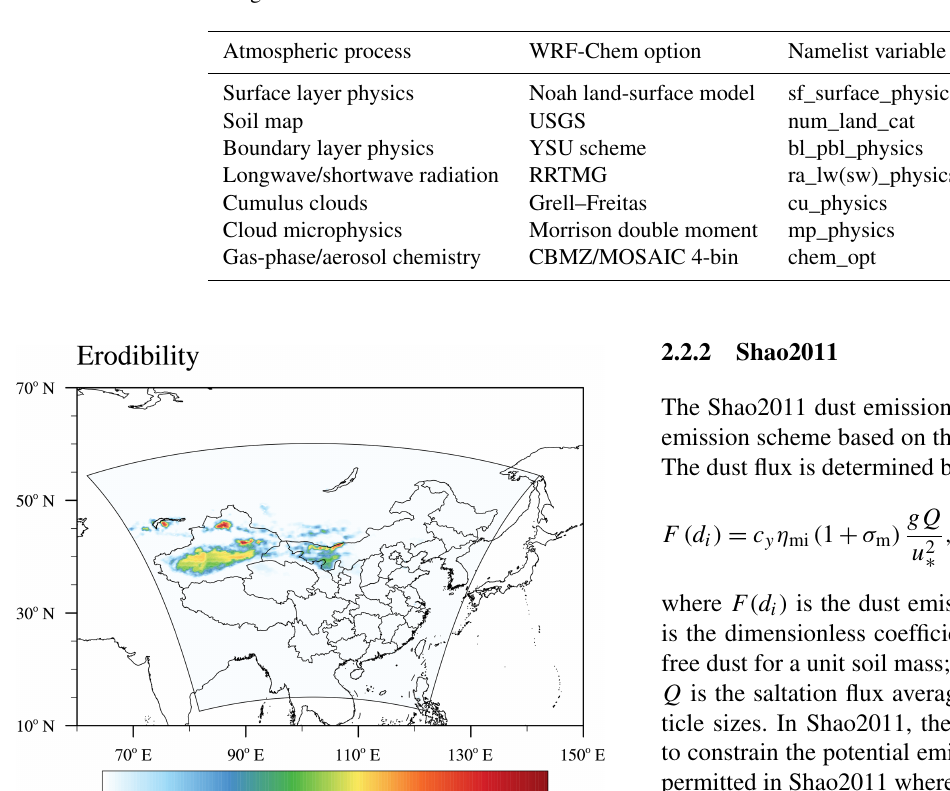
Table 1. WRF-Chem configuration.